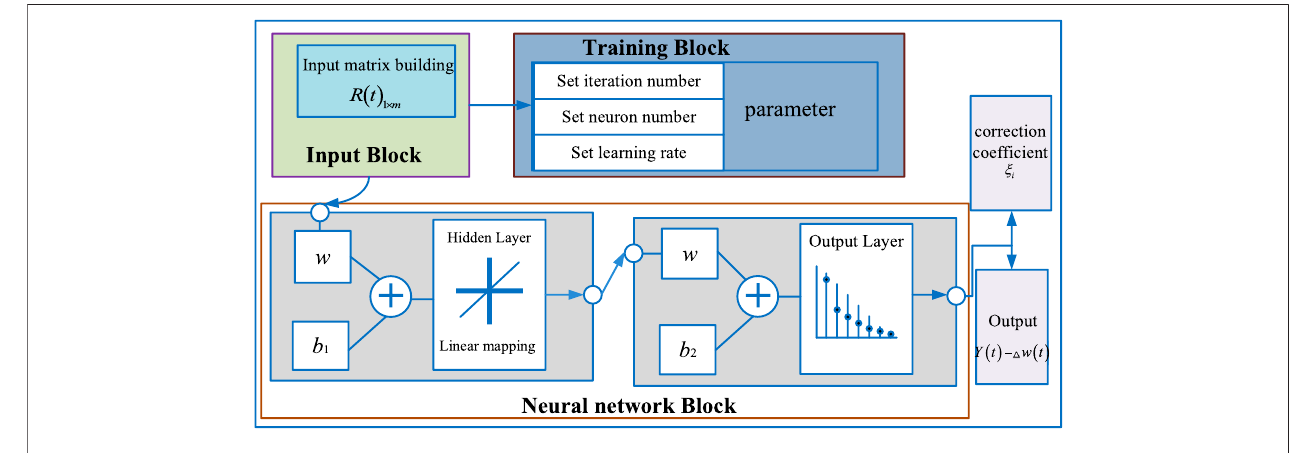
FIGURE 3 | The framework of our